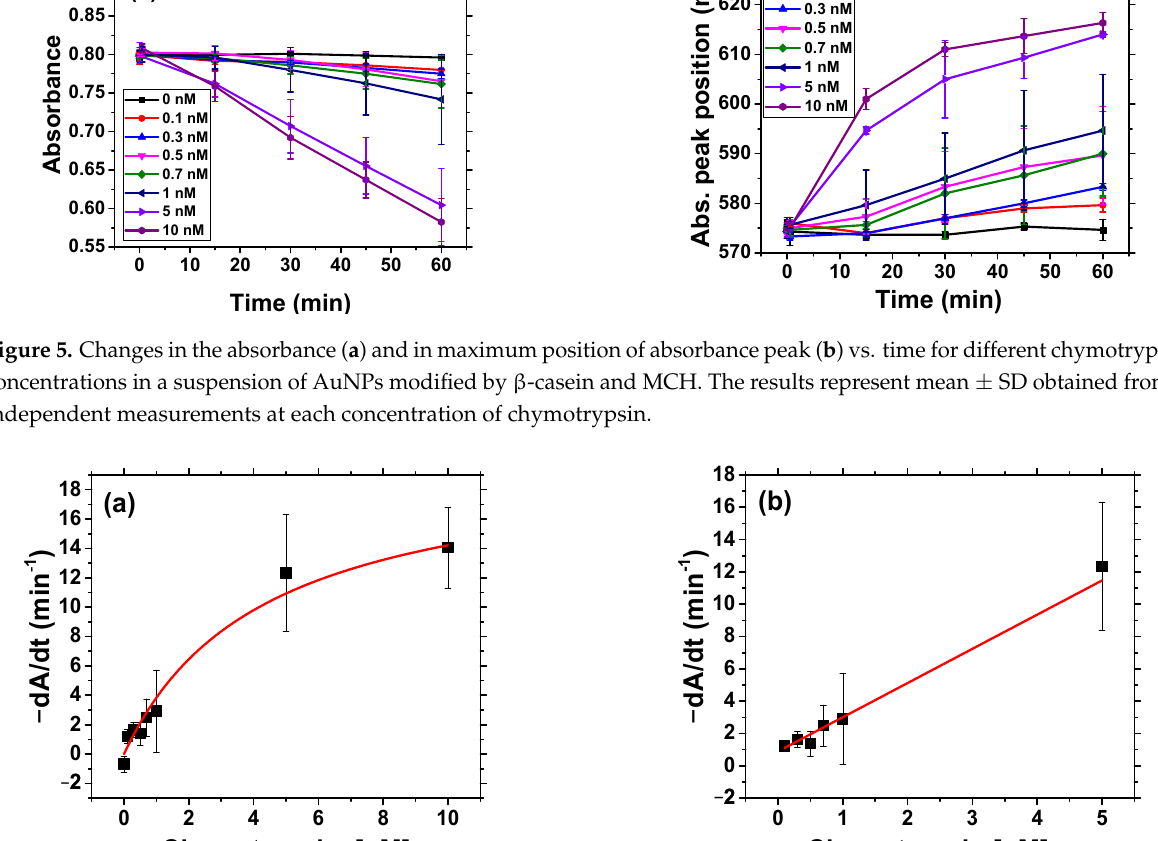
Figure 5. Changes in the absorbance ( a ) and in maximum position of absorbance peak ( b ) vs. time for different chymo- trypsin concentrations in a suspension of AuNPs modified by β -casein and MCH. The results represent mean ± SD ob- tained from 3 independent measurements at each concentration of chymotrypsin.